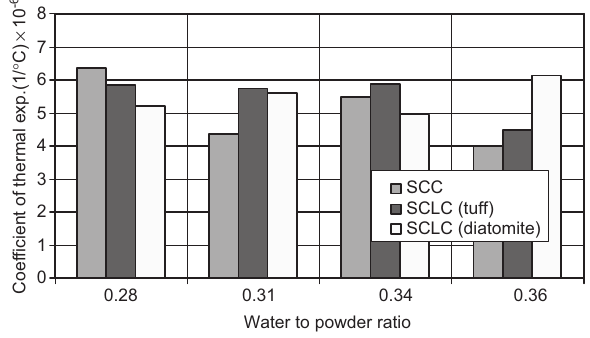
Figure 12 CTE of SCLC with tuff vs. temperature.